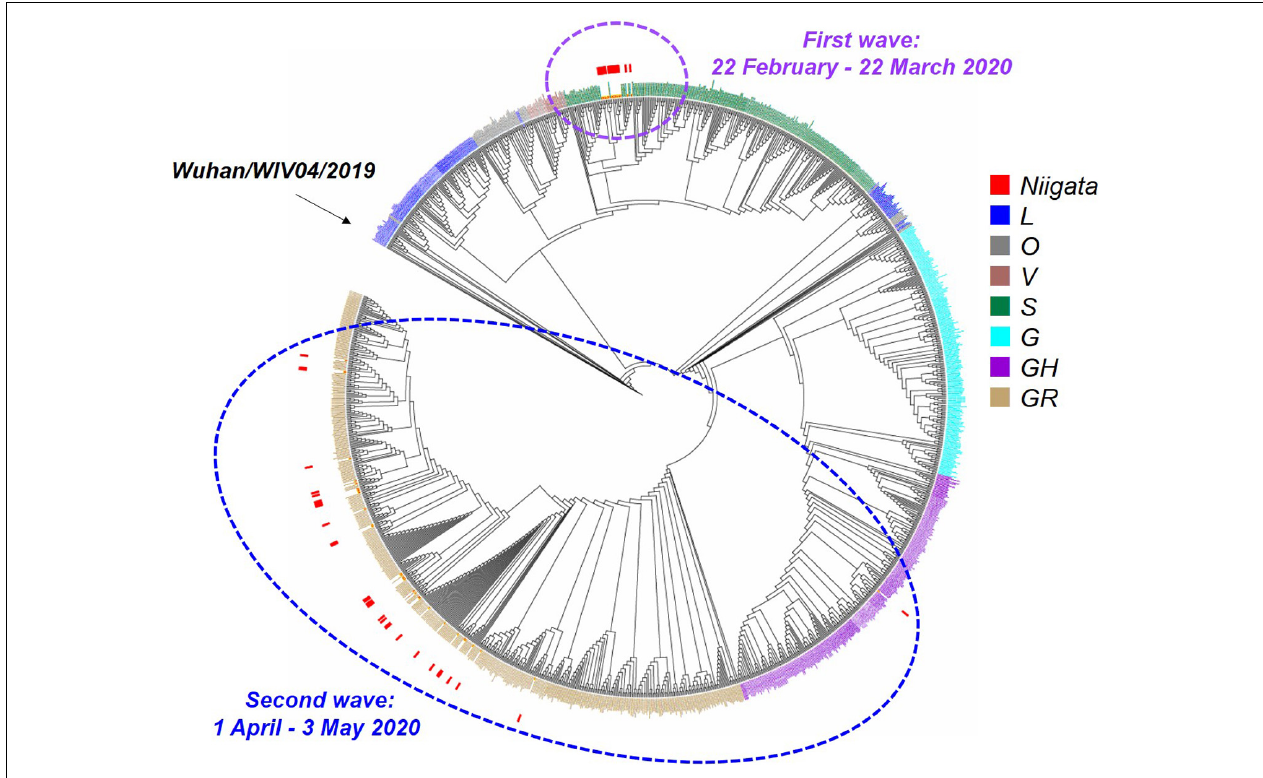
FIGURE 4 | Maximum likelihood phylogenetic analysis of SARS-CoV-2 in Niigata City, Japan, between February and May 2020 ( n = 47). This phylogenetic tree was based on the GISAID sequences of 781 global strains, 47 Niigata City strains, and 546 strains from other cities of Japan. The purple dotted circle represents the first wave by the date of onset (between 22 February and March 22, 2020) and the light blue dotted circle represents the second wave by the date of onset (between 01 April and May 03, 2020). Red squares indicate the strains detected in Niigata City, blue squares the L clade, mouse-colored squares the O clade, brown squares the V clade, dark green squares the S clade, light blue squares the G clade, dark purple squares the GH clade, and light brown squares the GR